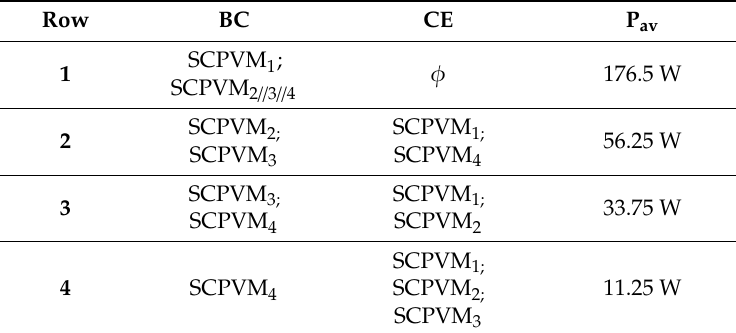
Table 4. Best clusters (BCs) and clusters of excluded (CEs) (Case I).